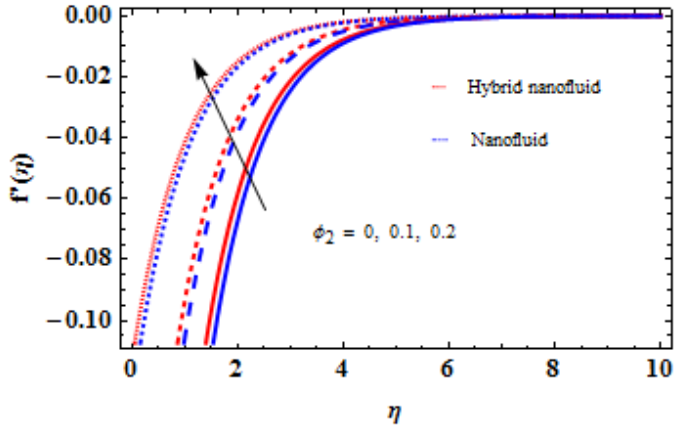
Figure 11. Influence of φ 2 via velocity field.